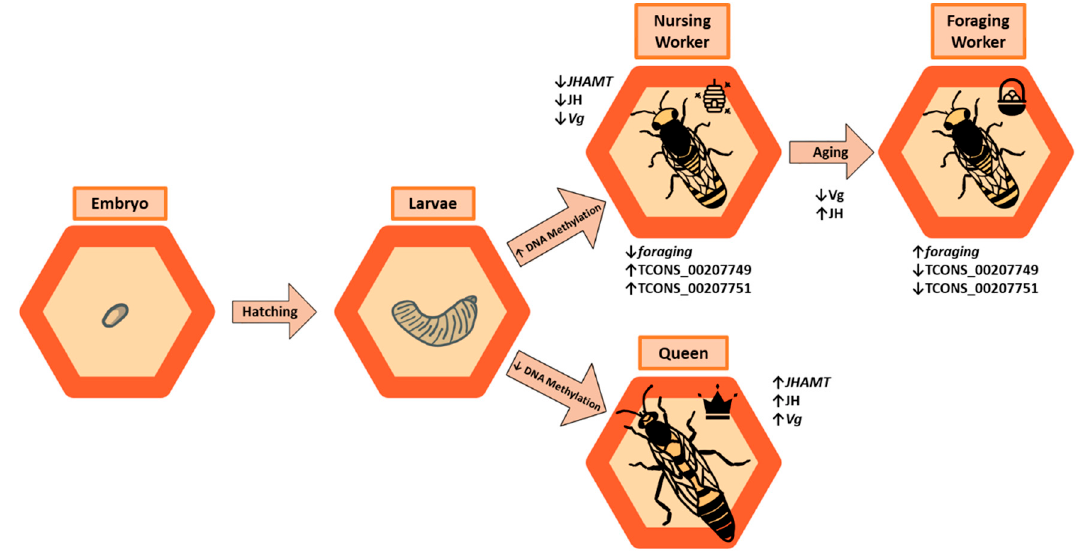
Figure 1. Epigenetic modifications occur at different points in the A. mellifera life cycle. Embryos hatch into larvae, which may develop into workers or queens. Workers overall possess a higher level of methylation than queens, opposing the case in bumblebees and ants. Honeybee workers also possess decreased expression of JH synthesis genes. As workers age, they switch from a nursing behavioral phenotype (signified by the hive icon) to a foraging behavioral phenotype (signified by the basket icon). This switch is associated with decreased Vg and increased JH production, as well as expression differences in the foraging gene and associated lncRNAs.